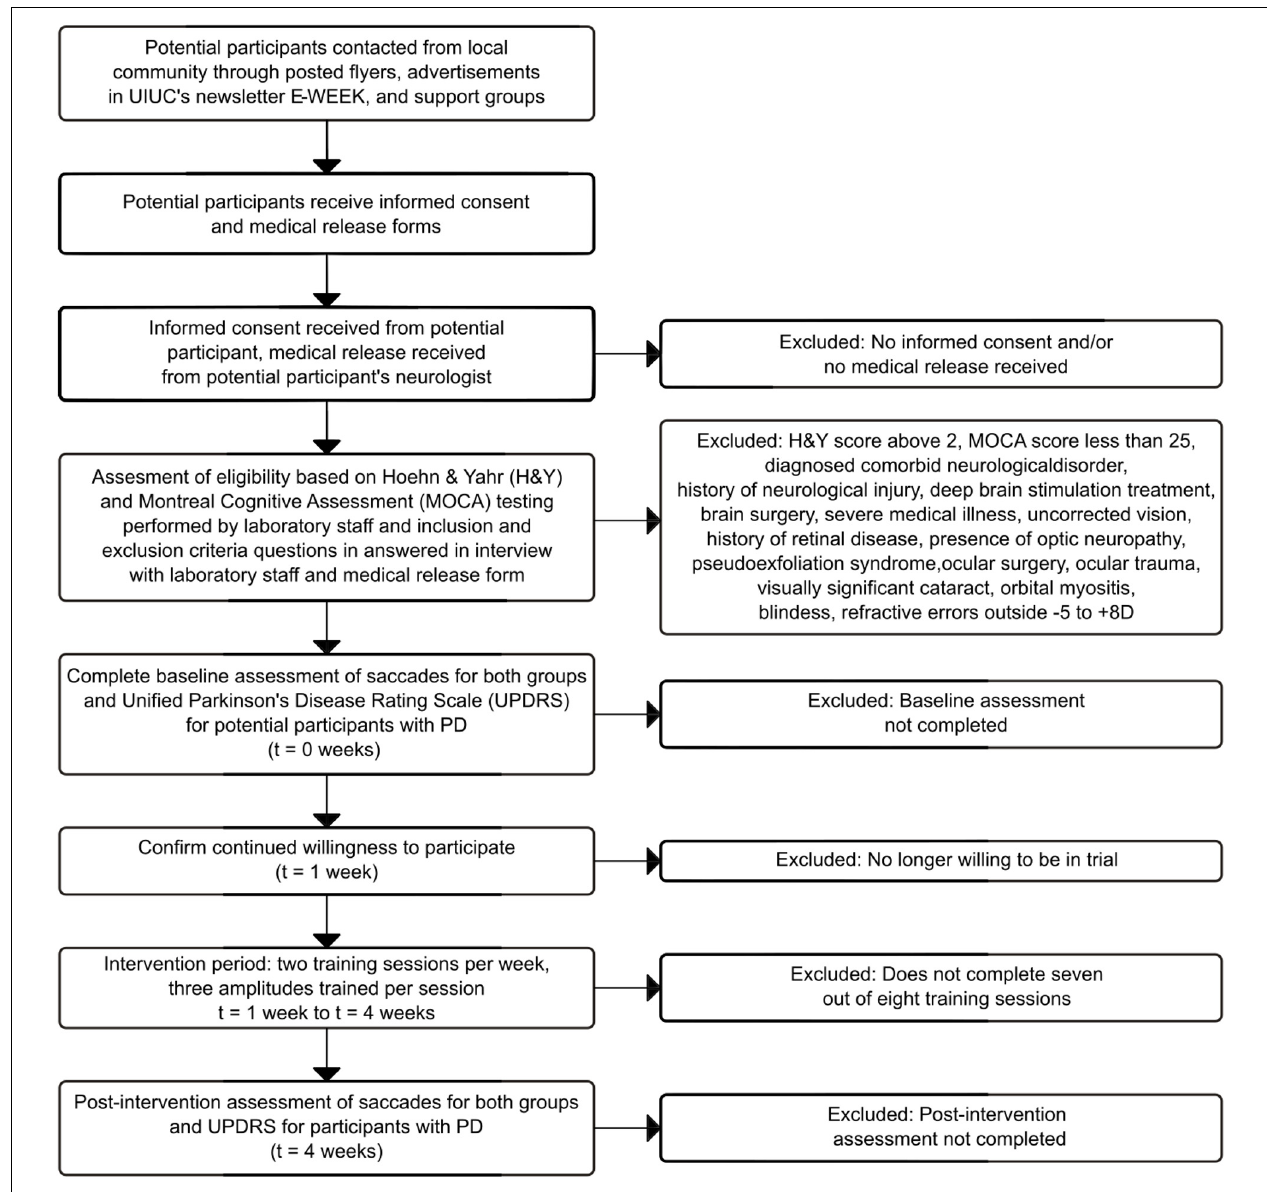
FIGURE 2 | Participant flow